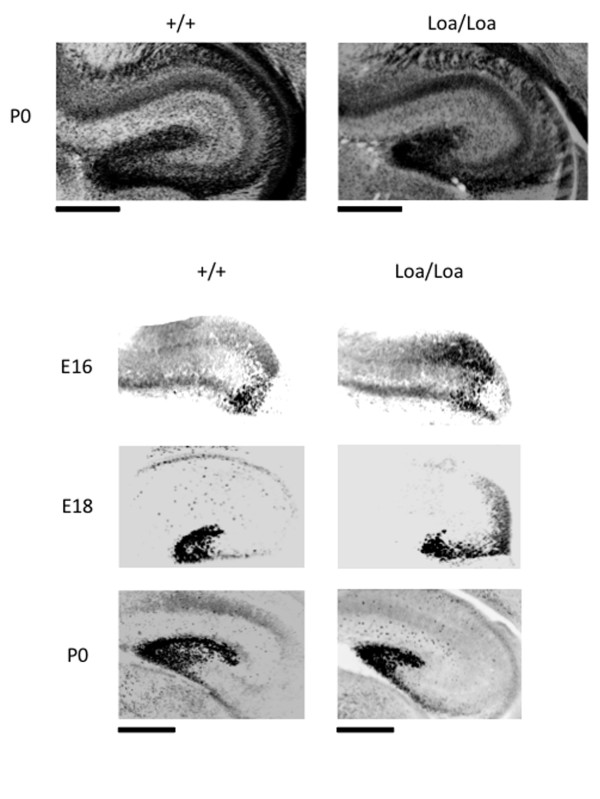
Loa mutant mouse brains exhibit a delay in hippocampal radial migration. (A) P0 brain slices stained with DAPI reveal a normal hippocampal structure, but a smaller dentate gyrus in the Loa/Loa compared with wild-type brains. (B) Embryonic day (E) 16, E18 and P0 brains were stained with Prox-1, a marker for granule neurons that migrate to form the dentate gyrus of the hippocampus. The progression of Prox-1-labeled neurons is delayed in the Loa/Loa brain compared with the wild-type brain. Scale bars = 200 μm.